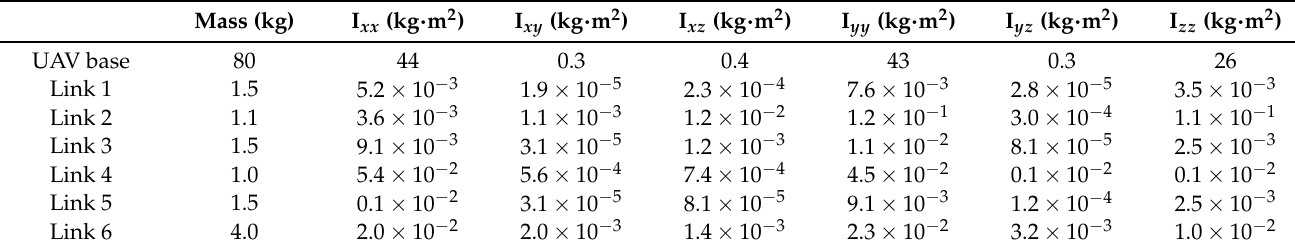
Table 2. Physical parameters of the AEROM system.